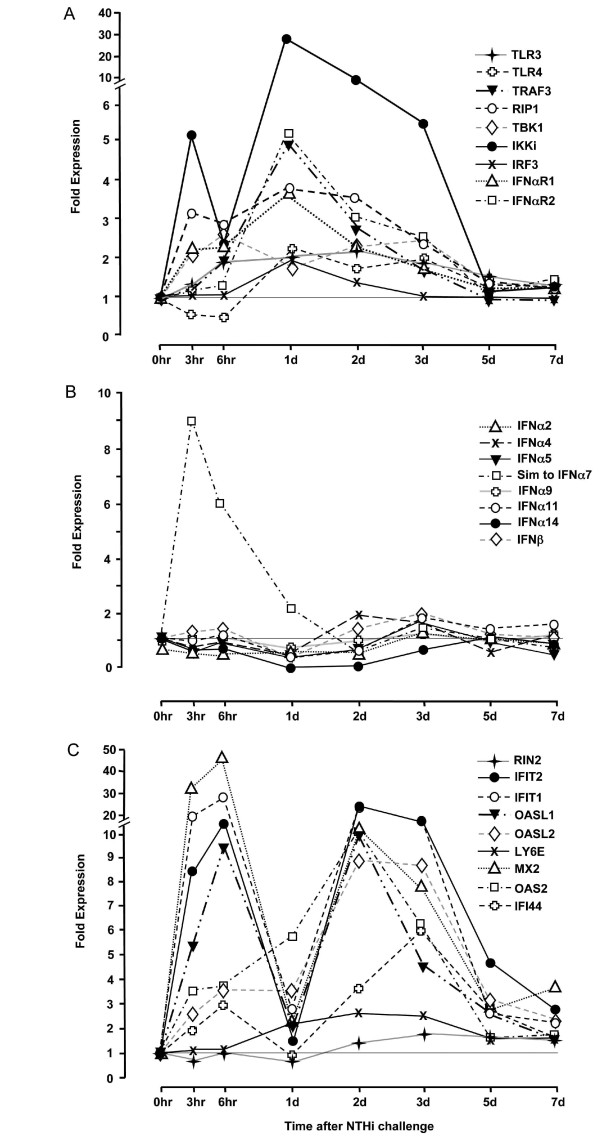
ME expression of genes related to TRIF signaling during OM, evaluated by microarray in WT mice. 3A. TRIF signaling genes. mRNA encoding genes of the TRIF signaling pathway (see Figure 1) in the ME mucosa. Data are expressed as fold induction over untreated ME mucosa (0 h). Each data point represents gene arrays obtained from 2 independent sets of 20 C57BL/6J mice each. 3B. Type I IFN genes. Not all IFNα genes are represented on the Affymetrix gene chip. However, data from those present are shown. View Within Article 3C. Type I IFN-induced genes. A number of genes are recognized as being induced by type I IFNs. Some of these genes also have ISREs in their promoters and can be directly activated by IRFs. A set of genes previously identified as being induced by IFNβ treatment in leukocytes [35] was assessed in the ME by gene array. (Detailed data including ranges and statistical significance are provided in Additional Files 1, 2 &3.)